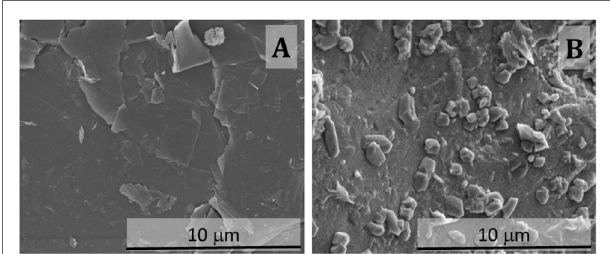
FigUre 4 | secondary electron micrographs of fractured sections of non-carbonated alkali-activated slag/metakaolin binders with gbFs/ (gbFs + MK) ratios of (a) 1.0 and (b) 0.9